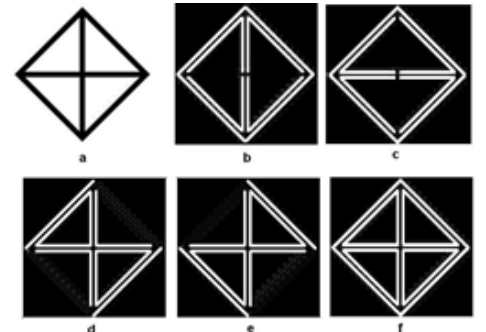
Figure 1. Parts of a Gabor filter output: (a) original image (b) Gabor-energy, (c) Real, and (d) Imaginary. The value of the Gabor filter generation parameters are as follow: